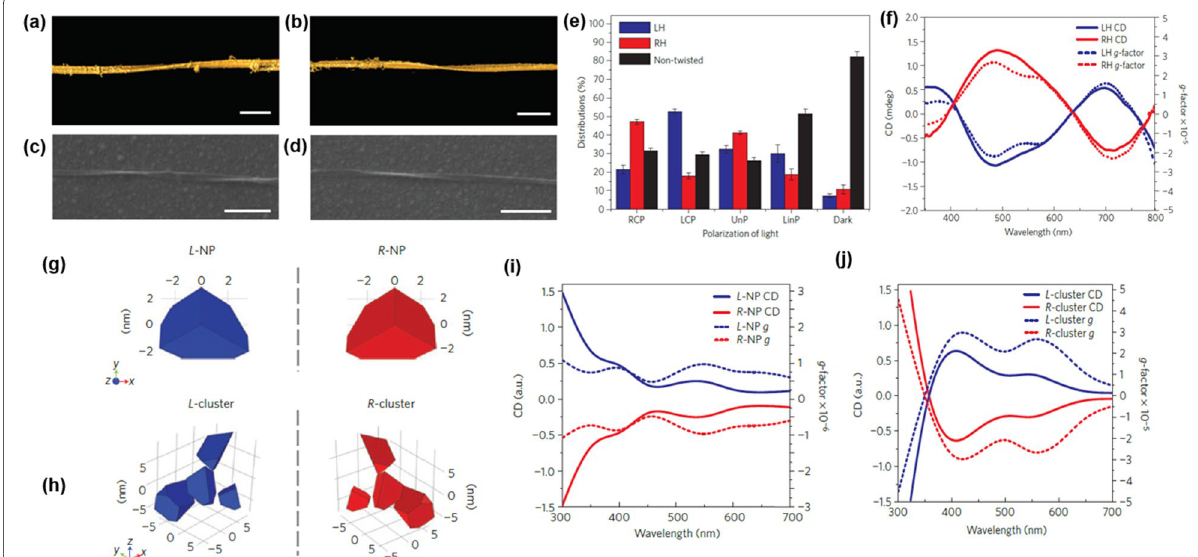
Fig. 15 a , b 3D TEM tomography of a LH and b RH single twisted nanoribbons. Scale bars, 100 nm. c , d SEM images of c LH and d RH single twisted nanoribbons. Scale bars, 500 nm. e Distributions of LH, RH and non-twisted nanoribbons yielded after 50 h illumination under RCP, LCP, unpolarized light, linearly polarized light, and in the dark. f CD spectra (solid line) and g-factors (dotted line) of LH and RH twisted nanoribbons obtained after 50 h illumination. g , h Models of chiral NPs ( g ) and chiral NP clusters ( h ) used in calculations of the chiroptical properties. i , j Simulated spectra and g-factors for chiral NPs and chiral NP clusters. Reproduced with permission from [91]. Copyright 2015 Nature Publishing